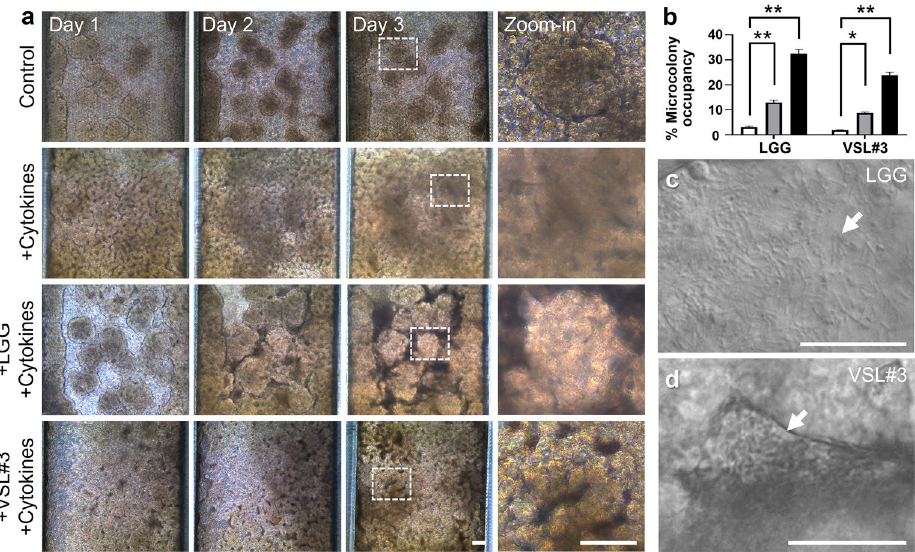
Figure 3. Morphological monitoring of the epithelial cells co-cultured with probiotic bacteria in a Leaky Gut Chip. ( a ) Phase-contrast micrographs of the morphological changes of epithelium challenged to a cytokine cocktail followed by the co-cultures with live LGG (+ LGG + Cytokines) and VSL#3 cells (+ VSL#3 + Cytokines) on days 1, 2, and 3. The image at “zoom-in” was enlarged from the location indicated in a dashed box in Day 3. ( b ) Quantification of the colonized area by either LGG or VSL#3 cells (% Microcolony occupancy) on the cytokine-challenged epithelium for 3 days (n = 3 per chip). The white, grey, and black columns indicate day 1, 2, and 3, respectively. A snapshot with a high-power magnification of LGG ( c ) or VSL#3 cells ( d ) co-cultured on a leaky epithelium. The DIC micrographs in ( c ) and ( d ) were captured from the real-time videos taken on Day 3 of the co-cultures provided in Supplementary Video S1 (LGG) and S2 (VSL#3), respectively. An arrow indicates the location of a microcolony. Bars, 50 µm. * p < 0.05, ** p <